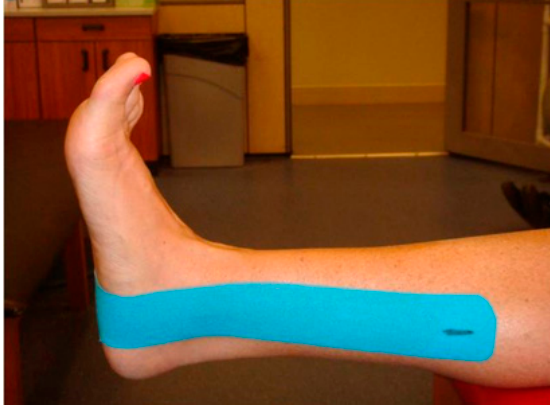
Figure 2. Medial view of the first strip of Kinesio tape.